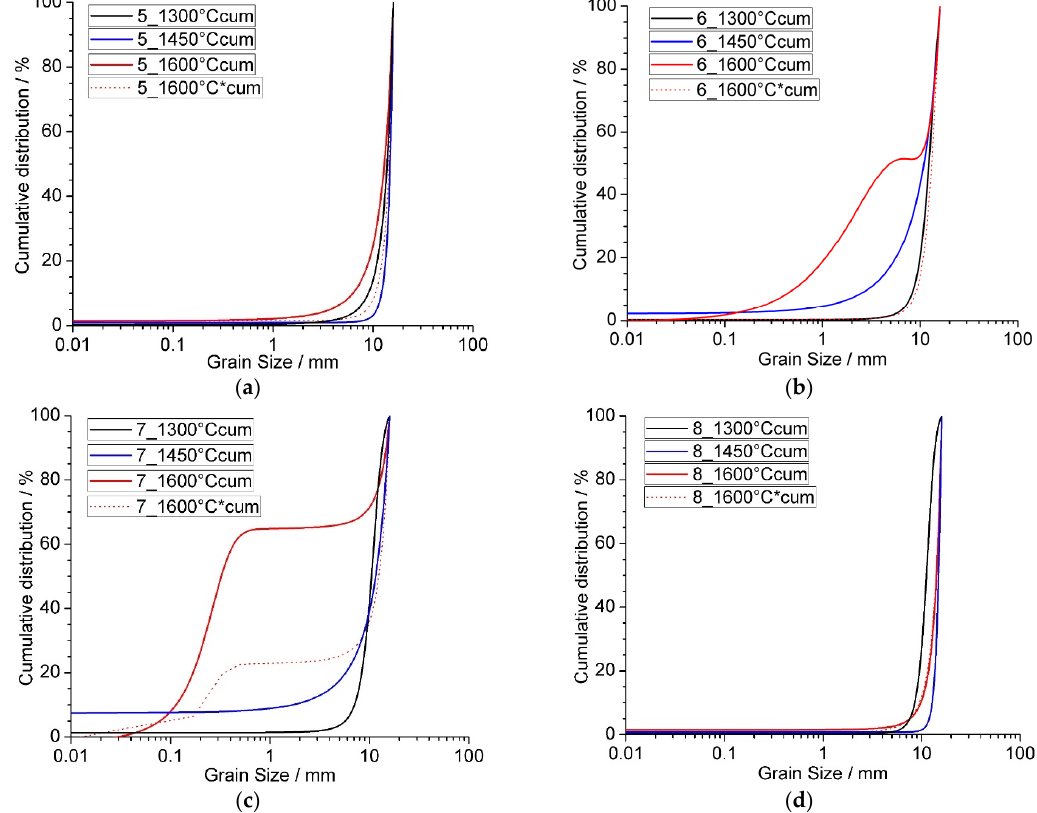
Figure 8. Cumulative curves after thermal and mechanical stressing of quartzites. ( a ) Quartzite Slovakia ; ( b ) quartzite Sweden ; ( c ) quartzite Poland ; ( d ) quartzite Ukraine .